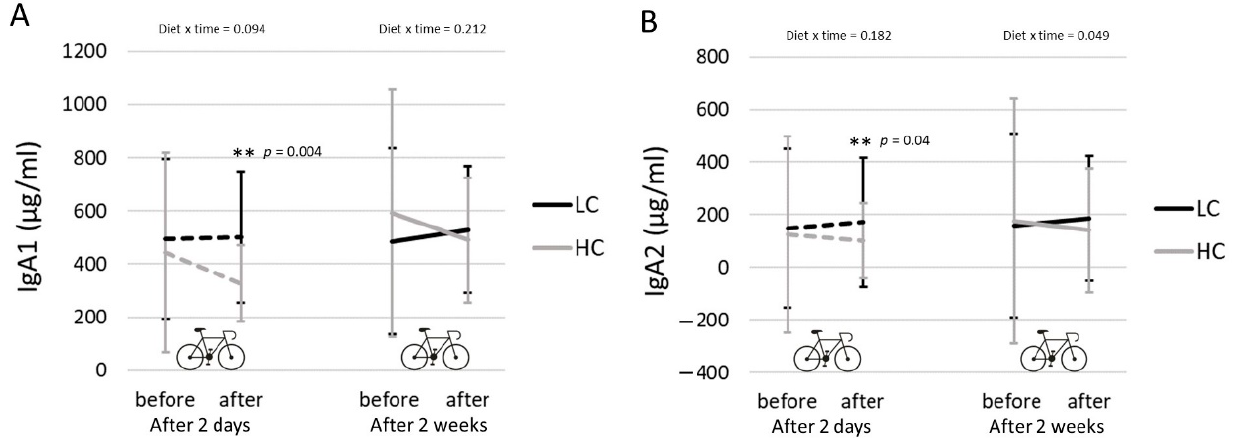
Figure 3. Salivary IgA levels. Salivary IgA1 ( A ) and IgA2 ( B ) levels (mean ± SD) before and after exercise, measured after 2 days on the LCHF diet (black dotted lines) and HC diet (grey dotted lines) and after 2 weeks on the LCHF diet (black continues line) and HC diet (grey continues line). Significant p values represent a paired samples t-test for the HC vs. LCHF diet.